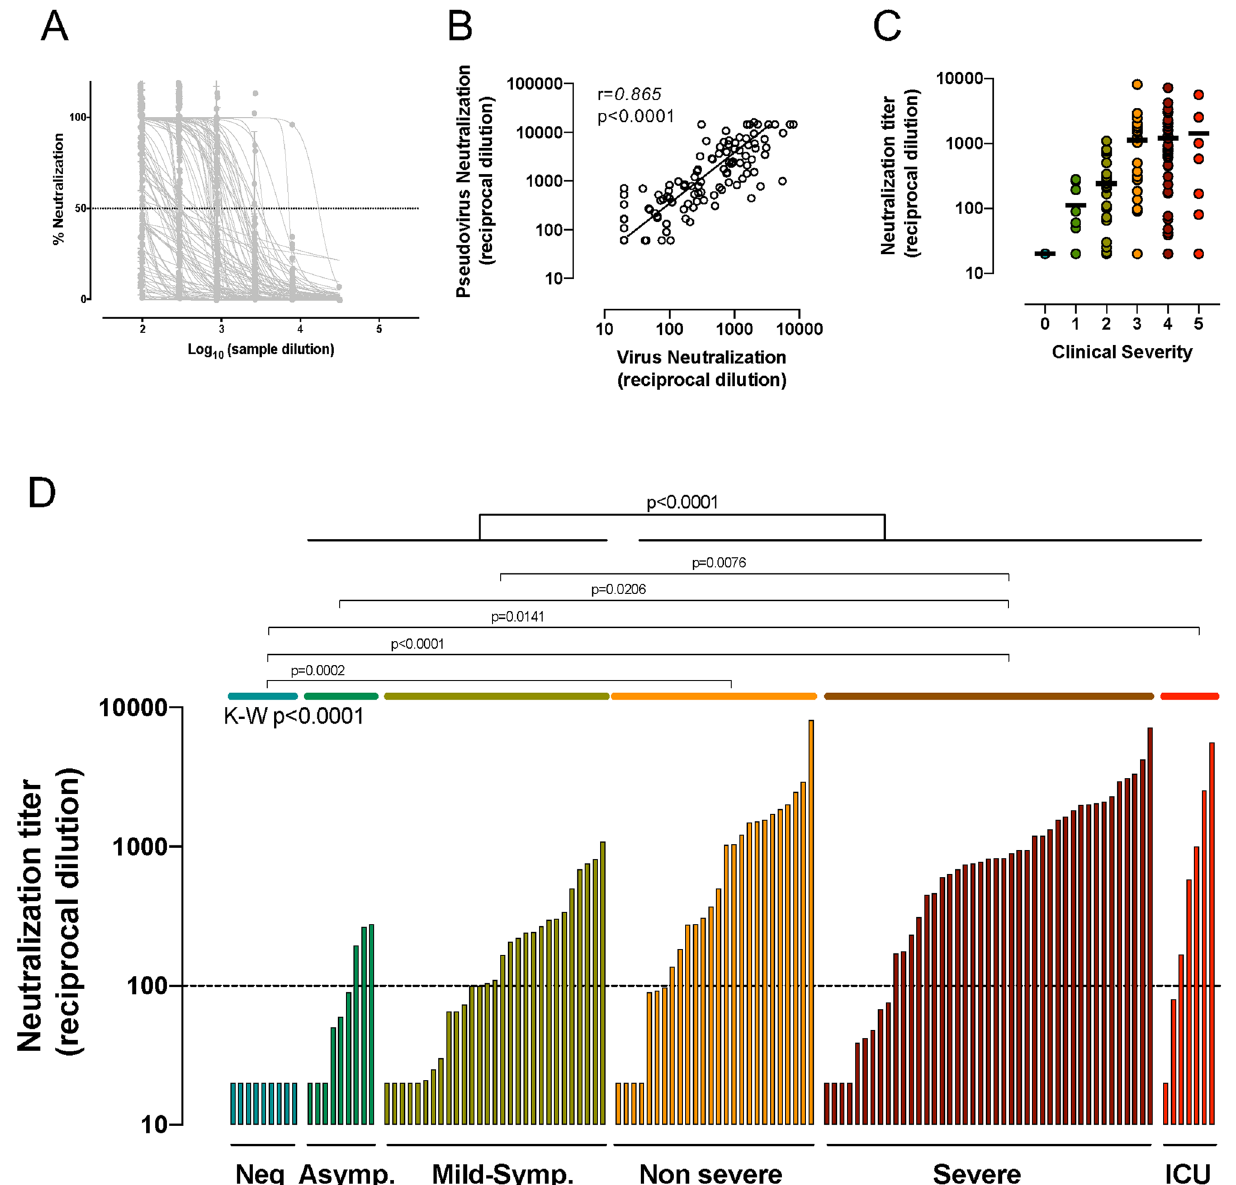
Figure 1. Neutralization activity. ( A ) Dose response of normalized neutralization data for all samples tested against replicative virus in Vero E6 cells (n = 130). ( B ) Correlation between IC 50 values of plasma samples in replicative virus and pseudovirus neutralization assays (n = 122). Line indicates linear regression for illustrative purposes. Correlation coefficient and p-value (Spearman correlation test) are shown. ( C ) Analysis of the impact of disease severity on neutralization titers (replicative virus assay) for the whole sample set. Individual values, mean values (solid lines) are shown for each group (0 = seronegative, 1 = asymptomatic, 2 = mid-symptomatic, 3 = hospitalized non severe, 4 = severe, 5 = ICU). ( D ) Calculated IC 50 (reciprocal dilution) in the replicative virus assay for all plasma samples tested grouped by SARS-CoV-2 positivity and clinical grade of symptoms. Comparison between groups was performed by Kruskal–Wallis test (p-value indicated in the Figure) with Dunn’s correction for multiple comparisons (indicated in intergroup comparisons). Top p-value indicates the comparison of the whole hospitalized and outpatient